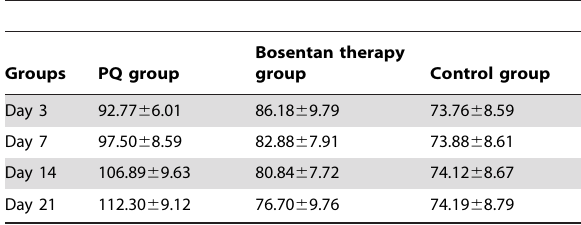
Table 1. Dynamic change of ET-1 in the serum from the three groups (mean 6 SD, ng/L).